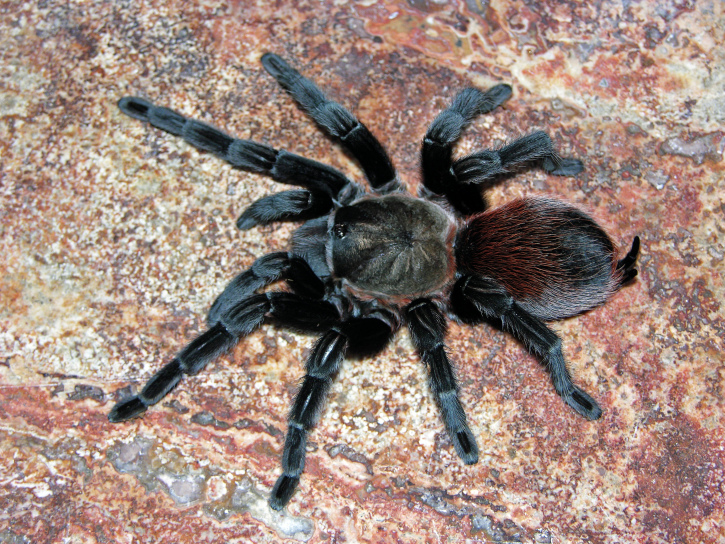
Brachypelma
kahlenbergi Rudloff, 2008 female near Veracruz, Veracruz state, Mexico. Photo: Rick C. West.